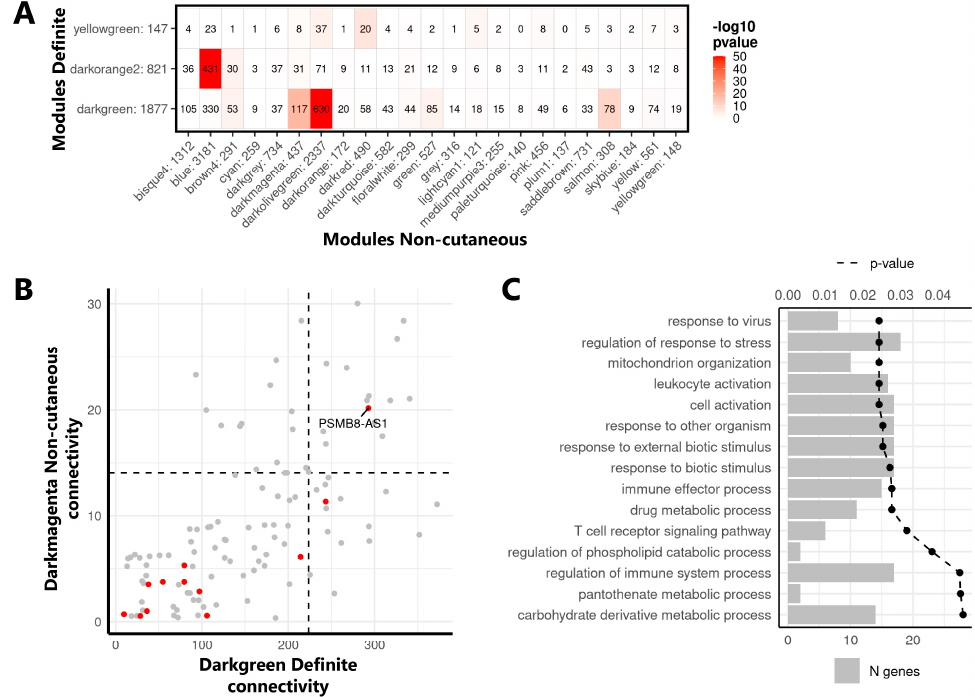
Figure 3. Identification of PSMB8-AS1 as a hub gene in replicated network modules. ( A ) Overlap of selected modules from the Definite (rows) and Non-cutaneous cohorts (columns). Numbers behind module names indicate the total number of genes in the modules. Numbers in the table indicate the number of genes overlapping between two modules. Coloring indicates the significance of the overlap (Fisher’s exact test, − 10log ( p -value)). ( B ) Intramodular connectivity of genes shared across the darkgreen module of the Definite cohort ( x -axis) and the darkmagenta module of the Non-cutaneous cohort ( y -axis). Each dot represents one gene, with lncRNAs highlighted in red. The top 25% most connected genes in both cohort modules (threshold indicated by black dashed lines) were considered as hub genes. ( C ) The GO-term enrichment of genes replicated across the darkgreen/darkmagenta modules. Bars depict the number of genes identified in the enrichment, the dotted line represents the B&H corrected p -value. Top 15 enriched terms are shown (B&H corrected p -value <